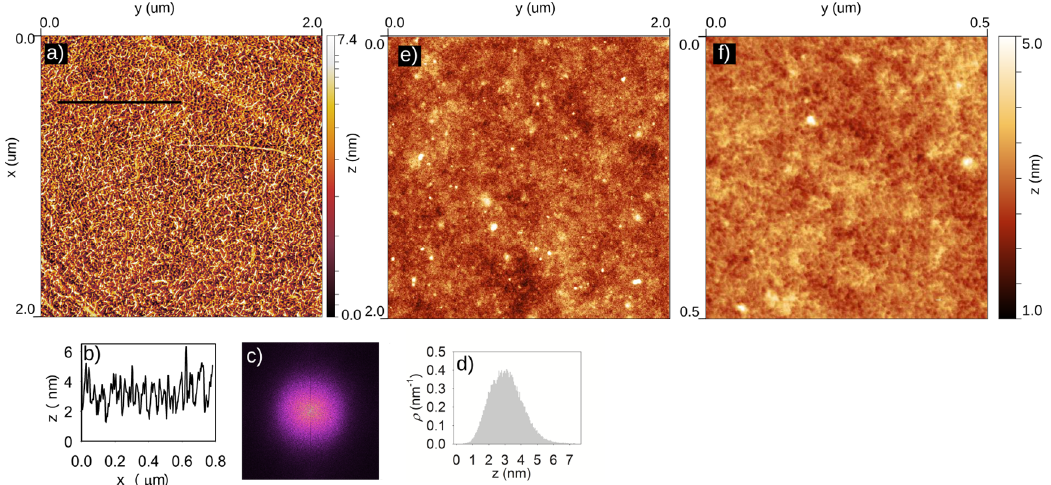
Figure 1. The atomic force microscopy (AFM) topography image of the wrinkled NC transferred graphene ( a ) with the cross-section (black line) in panel ( b ). The 2D FFT image of the AFM topography image ( c ), showing no orientation preference of wrinkles, and the height histogram of the topography image ( d ). ( e ) Large-scale AFM image of NC on a Si/SiO 2 substrate. ( f ) A close up AFM image of the NC on a Si/SiO 2 substrate as shown in ( e ).